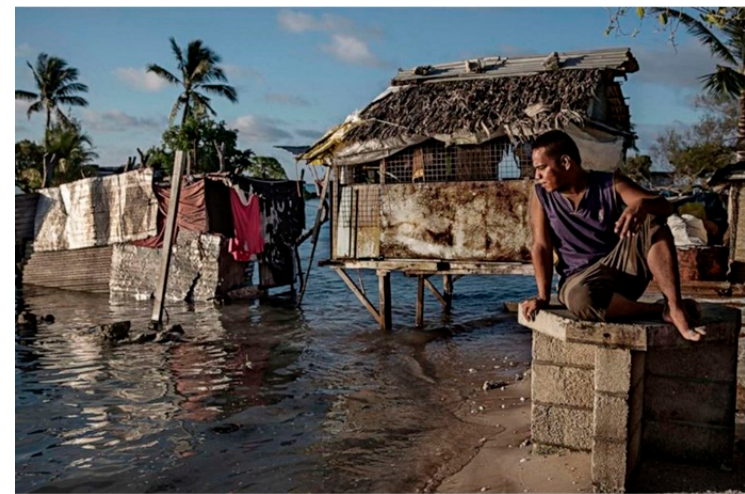
Figure A1. Stimulus Image for the Global Inequality Message.